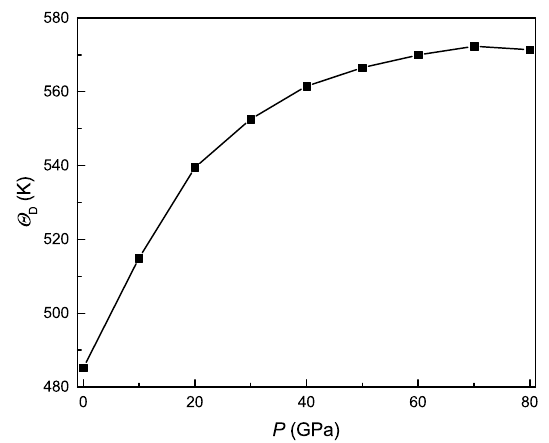
Figure 12. Debye temperature as a function of pressure for Ti 3